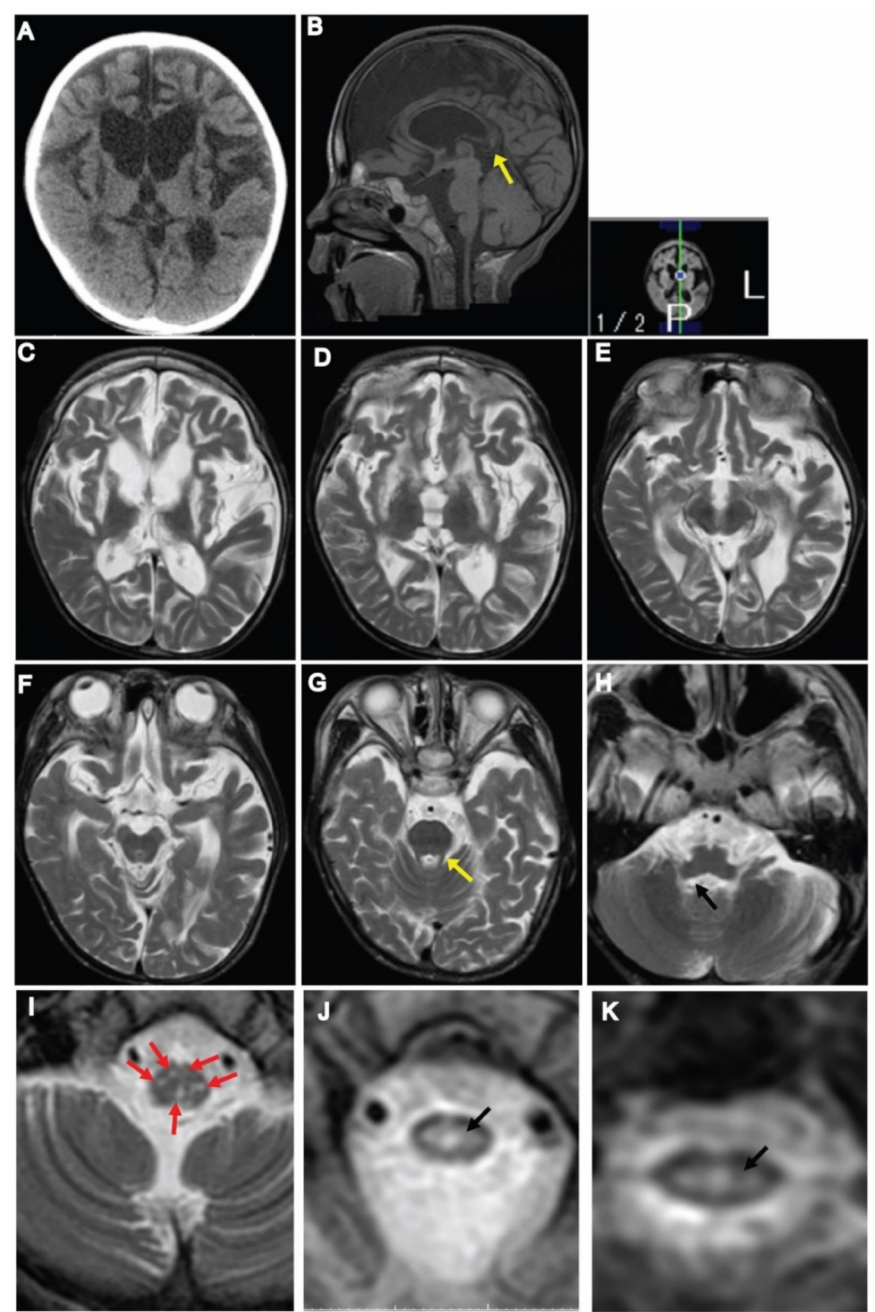
Figure 2. Neuroimaging findings at 13 years of age. ( A ) CT scan of the brain showing cerebral atrophy and ventricular enlargement. ( B ) Sagittal T1-weighted image of the brain showing ventricular enlargement, thinning of the corpus callosum with foci in the posterior body of the corpus callosum (arrow). ( C – E ) Axial T2-weighted images of the brain showing signal changes in the periventricular and frontal white matter, the putamen, caudate nucleus, corpus callosum, and anterior limb of the internal capsule. ( F – I ) Within the brainstem: ( F ) no signal abnormality was observed in the midbrain; ( G ) superior cerebellar peduncle (yellow arrow); ( H ) inferior cerebellar peduncle (black arrow); ( I ) T2-axial images of the medulla showing spotty high signal in the medulla (arrows), however pyramids and medial lemniscus decussation were preserved. ( J , K ) T2-axial image of upper cervical spinal cord showing high intensity area in the central part of the spinal cord